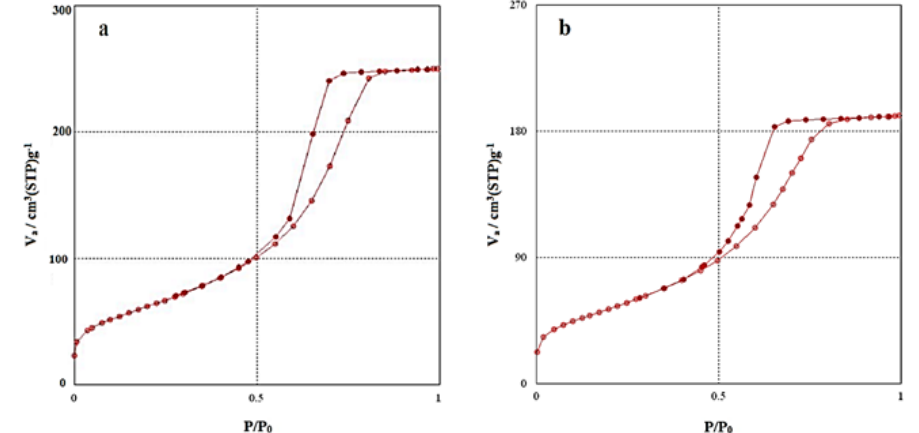
Fig. 4 . N adsorption and desorption isotherms, a) Al-B catalyst, b) Al-A catalyst 2